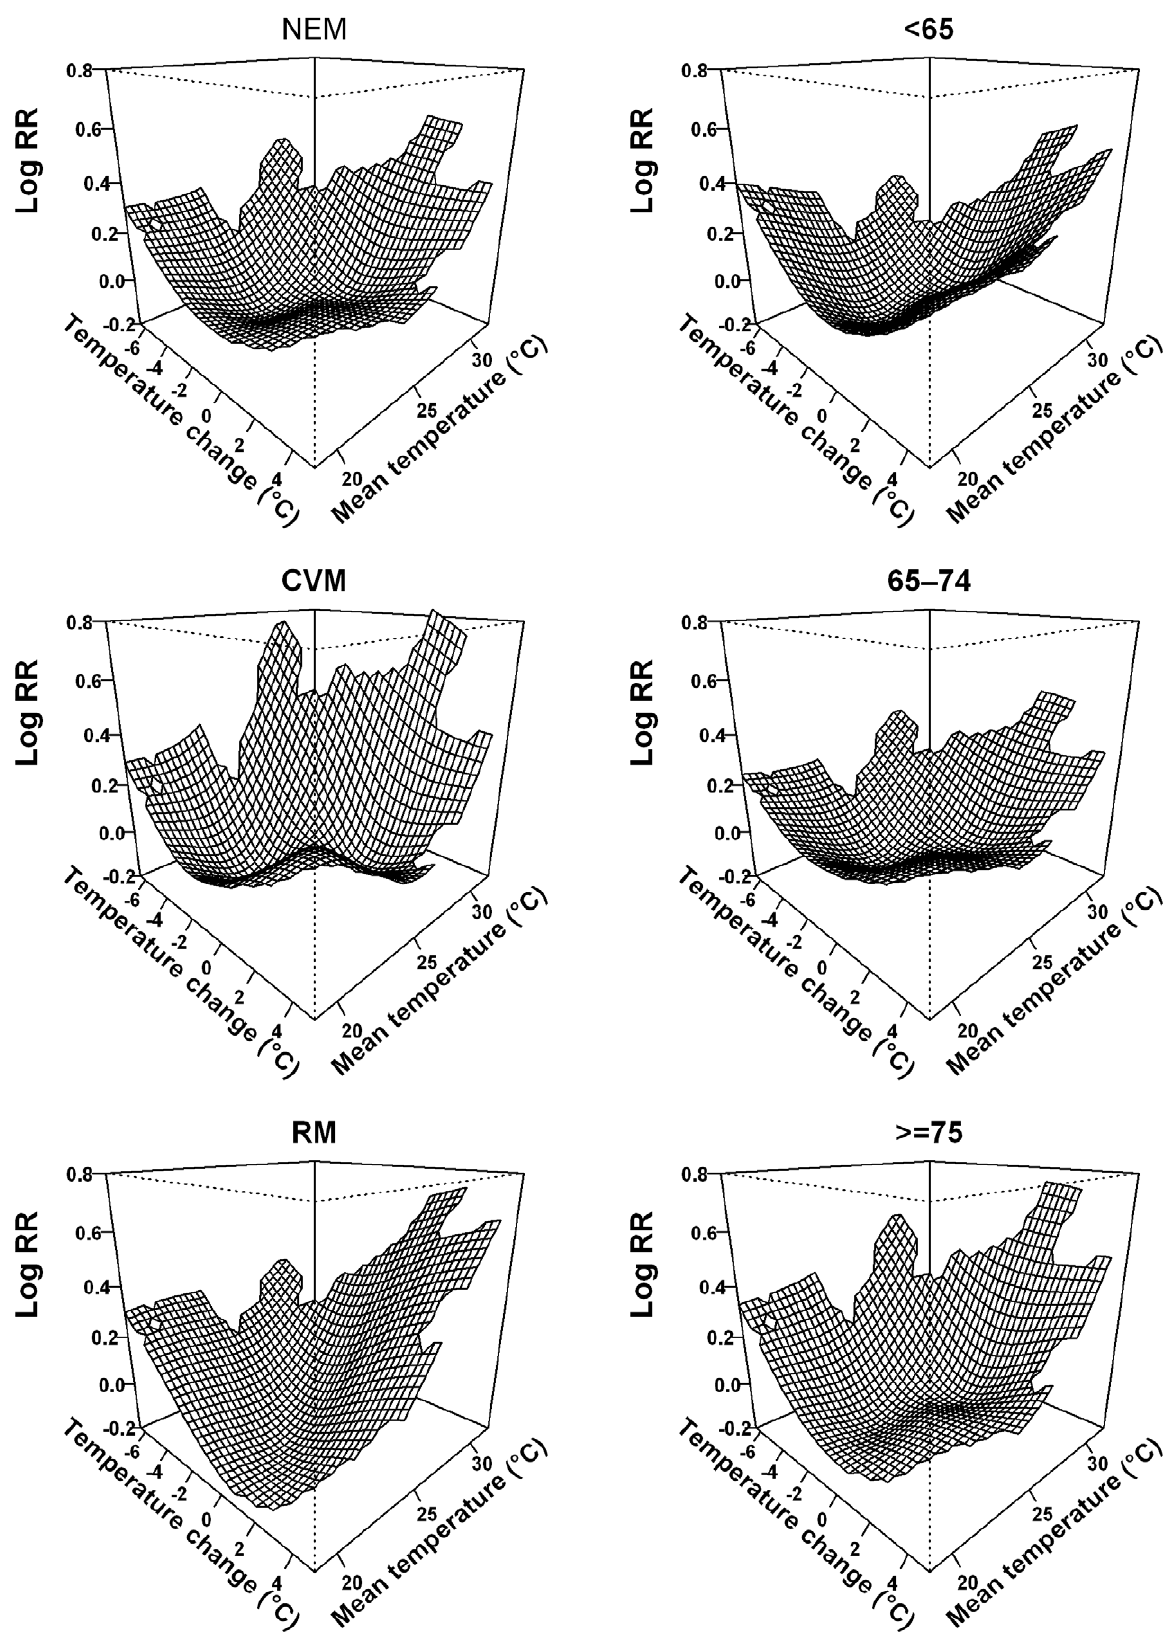
Figure 3. Bivariate response surfaces of the temperature change and mean temperature for non-external mortality, subgroups of mortality using model (3) in Brisbane, Australia. doi:10.1371/journal.pone.0016511.g003 PLoS ONE |